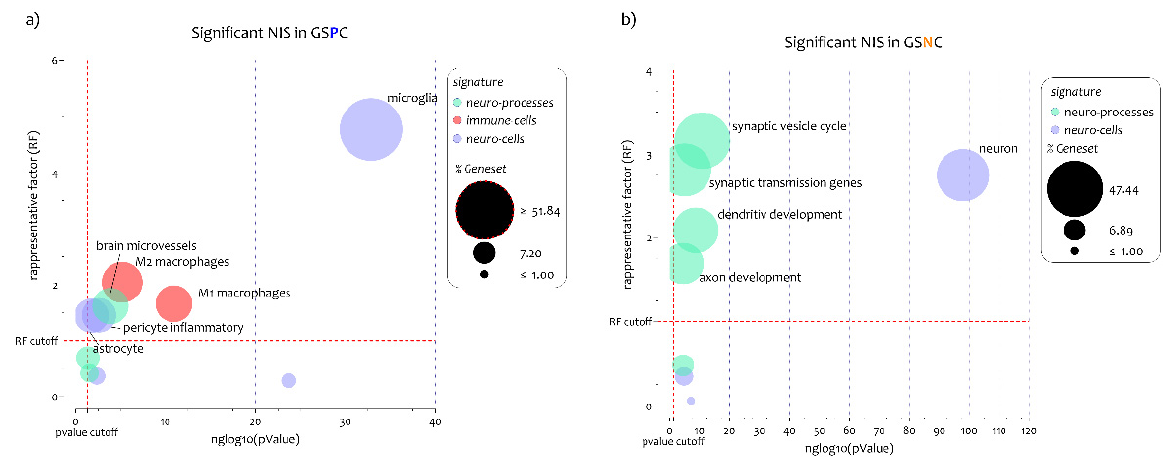
Figure 3. Significant intersection between neuro-immune signature and GSPC/GSNC-GJA1 in the spinal cord of ALS patients. ( a , b ) The intersection of gene lists positively (( a ), GSPC) and negatively (( b ), GSNC) correlated to GJA1 expression levels in ALS patients to the 17neuro-immune signature belonging to the CNS cells (n = 5), the immune cells (n = 7), and biological processes (n = 5). The genes in common obtained from the overlaps are expressed in percentages and represented as the size of bobble chart. The p -value obtained by Fisher’s test is expressed as neglog10 ( p -value) (abscissa axis). p -values < 0.05 were considered as statistically significant (neglog10 ( p -value) > 1.30). The representation factor is reported to the ordinate axis. A RF > 1 indicates more overlap than expected between the two independent groups, a RF < 1 indicates less overlap than expected, and a RF of 1 indicates that the two groups are identical by the number of genes expected to be independent in the groups.